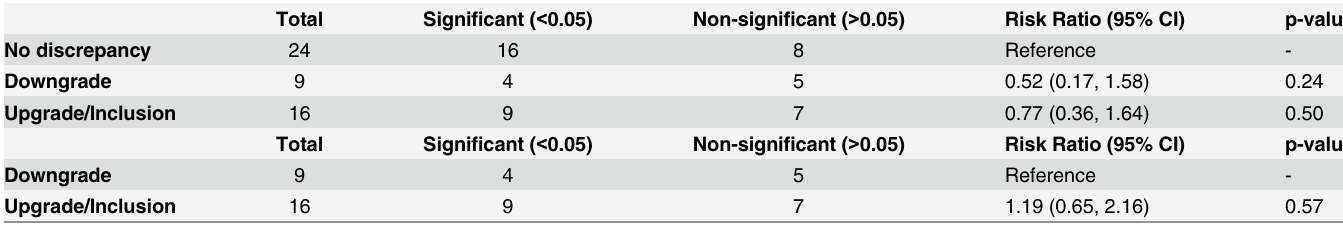
Table 4. Tabulation of counts, risk ratios and associated 95% confidence intervals and p-values per type of discrepancy and statistical signifi- cance for primary outcomes only. Total Signi fi cant ( < 0.05) Non-signi fi cant ( > 0.05) Risk Ratio (95%